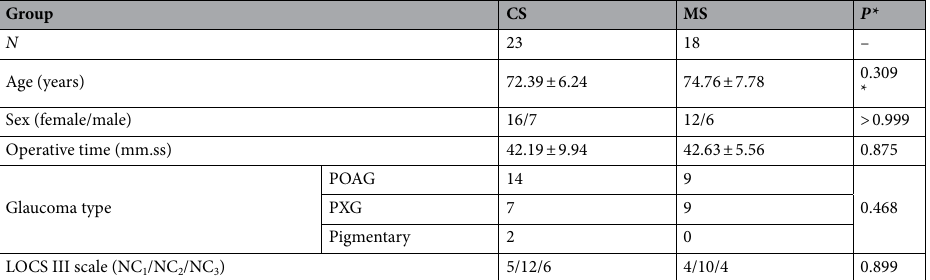
Table 1. Patient demographics. Data are presented as n or mean ± standard deviation; CS corneal suture, MS muscle suture, POAG primary open-angle glaucoma, PXG pseudoexfoliation glaucoma, PG